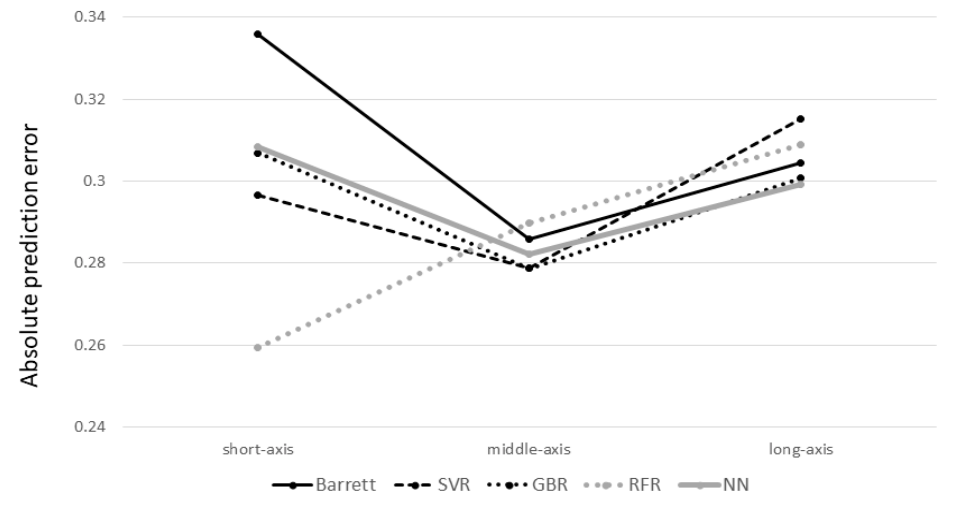
Figure 5. Mean absolute prediction error categorized according to the axial length. In the short-axis group, the mean absolute error for the Barrett Universal II formula, SVR, GBR, RFR, and NN were 0.3360, 0.2967, 0.3069, 0.2593, and 0.3085, respectively. In the middle-axis group, the mean absolute error for the Barrett Universal II formula, SVR, GBR, RFR, and NN were 0.2858, 0.2789, 0.2788, 0.2898, and 0.2821, respectively. In the long-axis group, the mean absolute error for the Barrett Universal II formula, SVR, GBR, RFR, and NN were 0.3045, 0.3153, 0.3008, 0.3089, and 0.2991, respectively. The p -value by the Friedman test was > 0.05 for all axial length subgroups.